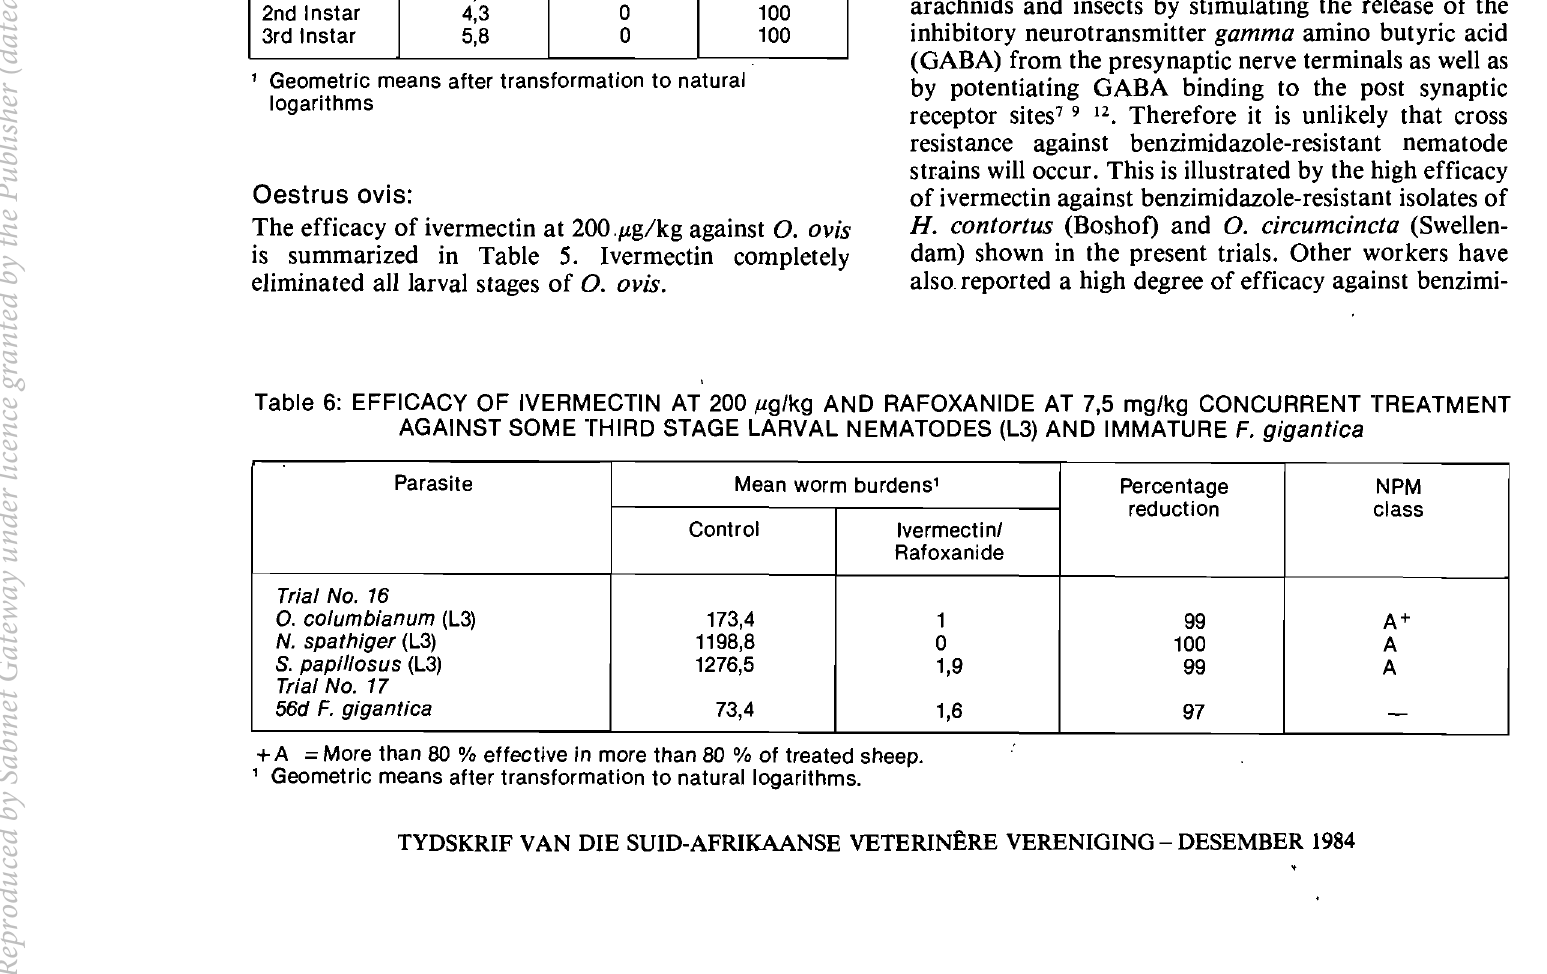
Table 5: EFFICACY OF IVERMECTIN AT 200 ,ug/kg AGAINST O. ovis